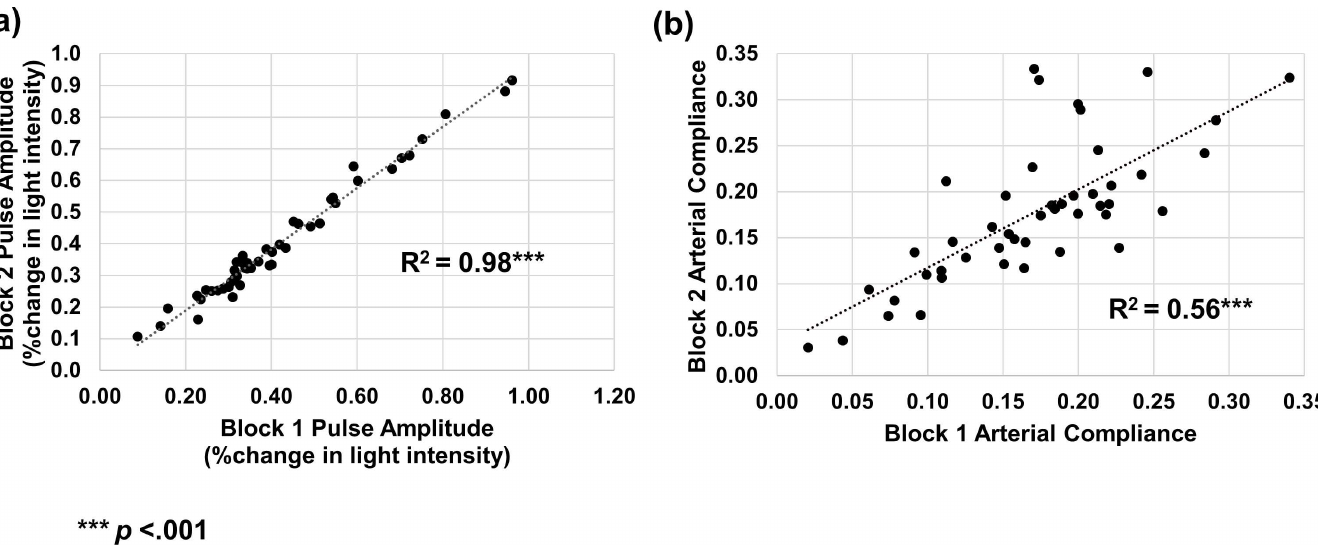
Fig 3. (a) Correlationbetweenblock 1 and 2 for pulse amplitude(expressed in percent change in light intensity). (b) Correlationbetweenblock 1 and 2 for arterial compliance (compliance is a dimensionless measure indicating the changeof the shape of the diastolicsection of the pulse from a straight line, with 0 indicating a straight, obliqueline, and 0.5 indicating a flat line lasting the wholedurationof the diastolefollowedby a vertical